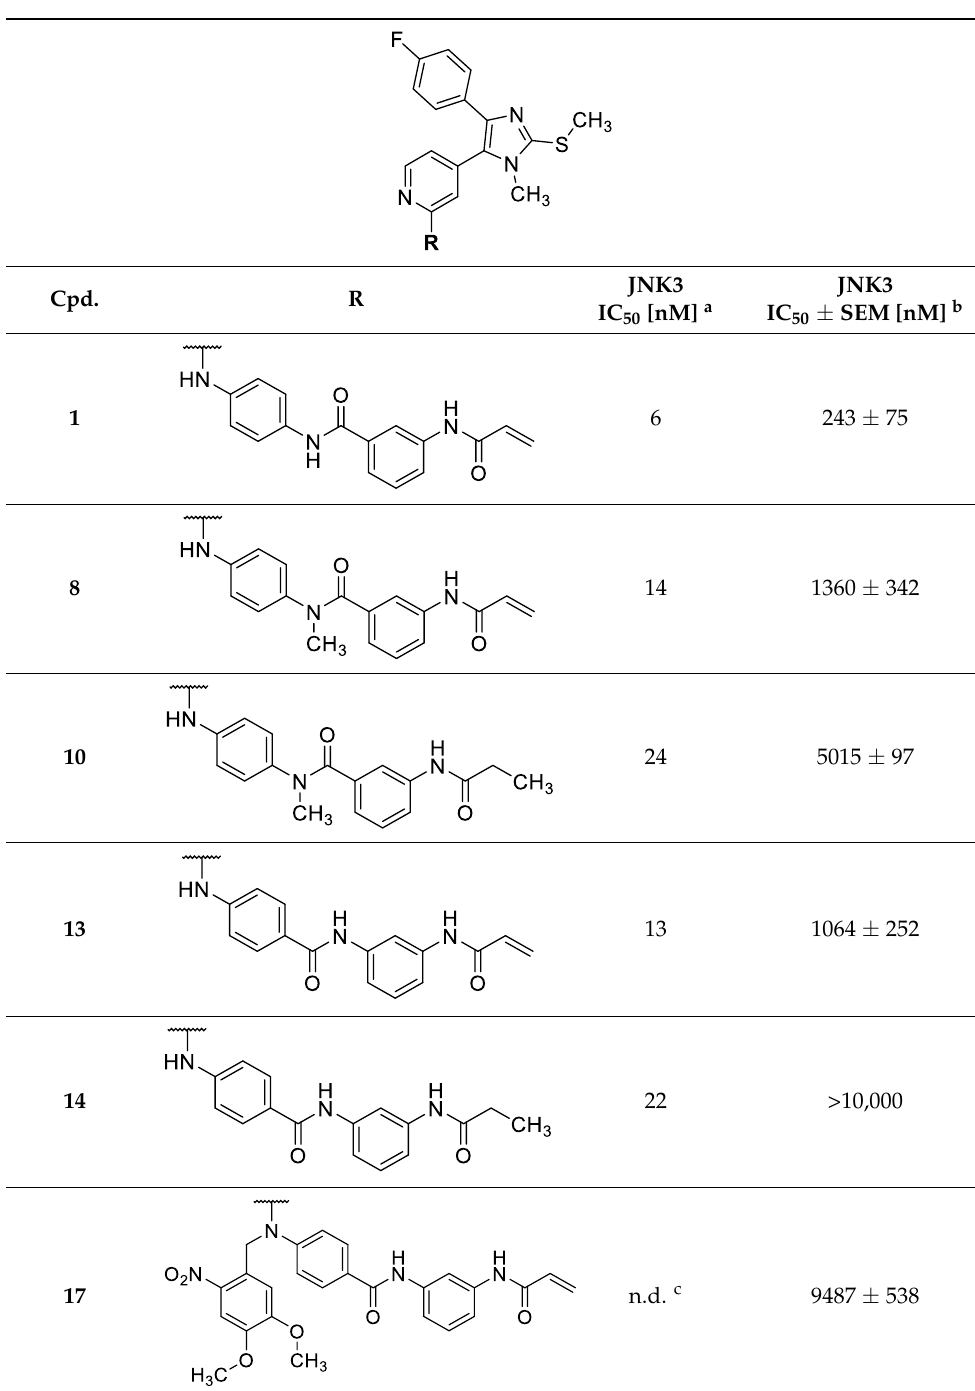
Table 1. Structures and biological activities of compounds 1 , 8 , 10 , 13 , 14 , and 17 .